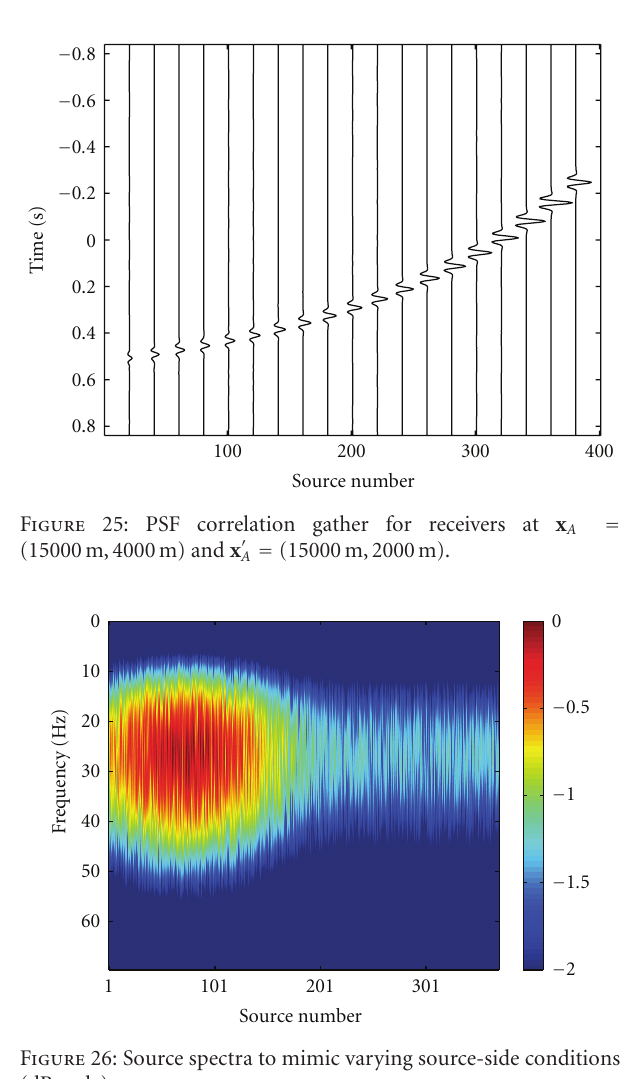
Figure 29: PSF for a virtual source at x A = (15000m,4000m) for a model with varying source spectra and a gas cloud; the red-blue plot is clipped at 20% of the maximum amplitude; the black and green traces represent true-amplitude temporal and spatial traces,